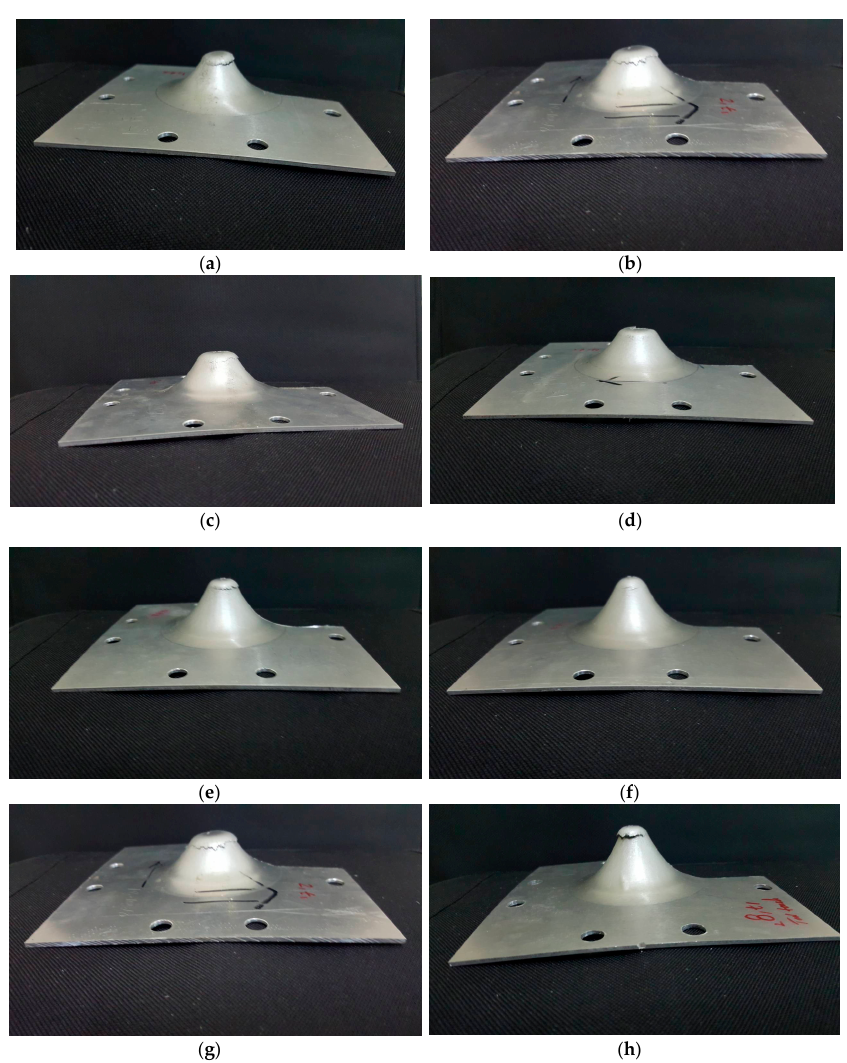
Figure 9. Fracturing of sample at the end of the eight experiments via the SPIF (single-point incremental forming): ( a ) run 1; ( b ) run 2; ( c ) run 3; ( d ) run 4; ( e ) run 5; ( f ) run 6; ( g ) run 7; and ( h ) run 8.